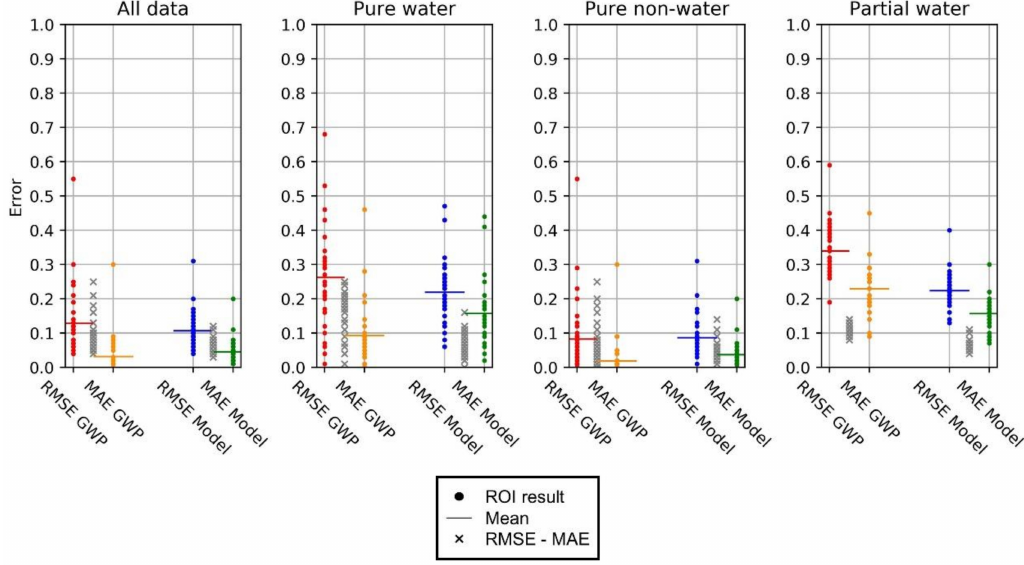
Figure 9. Model and GWP performance according to coverage categories for all